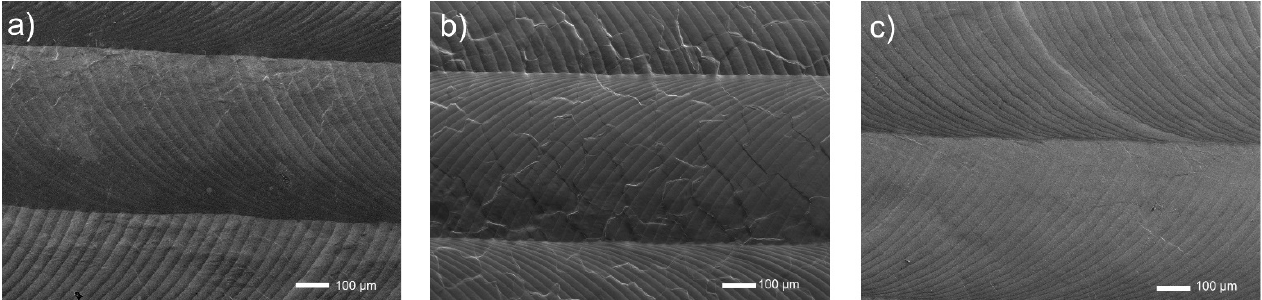
Figure 4. Microstructures of surfaces of titanium and its alloys, ground, and laser modified: ( a ) Ti, (b ) Ti6Al4V, ( c ) Ti13Nb13Zr.